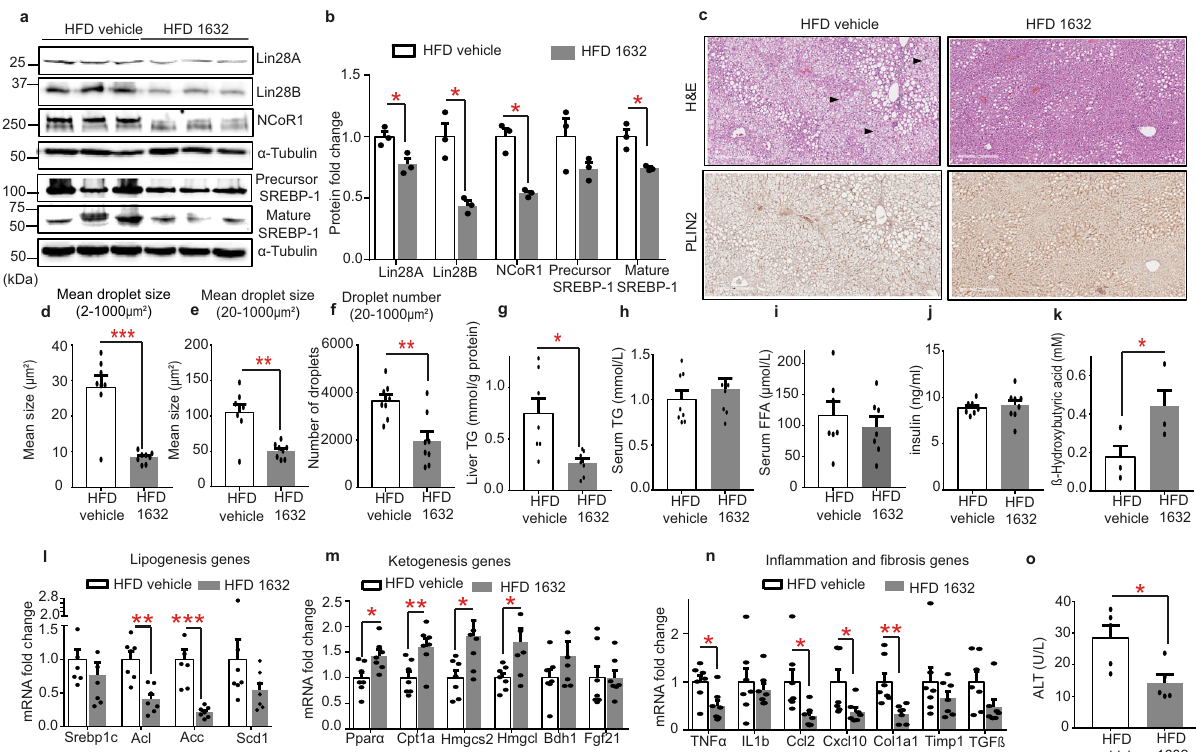
Fig. 6 | C1632 protects against high-fat diet (HFD)-induced NAFLD in mice. a , b Representative immunoblot and quantitative densitometric analyses for Lin28A, Lin28B, NCoR1 and SREBP-1 (precursor and mature form) in liversfrom 17- week-old male wild-type mice fed with HFD treated with vehicle or C1632 (50mg/ kg) after 4 weeks of treatment (5 IP injections per week). α -Tubulin was used as a loadingcontrol( n =3mice/group,Lin28A,* P =0.0272;Lin28B,* P =0.0258;NCoR1, * P =0.0167;M-SREBP1,* P =0.0467). c RepresentativeHematoxylinandeosin(H&E) staining and Perilipin (PLIN2) staining of liver sections from vehicle and C1632 (50mg/kg)-treated mice fed with a HFD. The arrowheads indicate ballooned hepatocytes. Scale bars correspond to 500 μ m. d – f Lipid droplet size and number were quanti fi ed by Image J ( n =8 histological images/group, d , *** P =0.0004; e , ** P =0.0018; f , ** P =0.0034). g Hepatic triglyceride (TG) content in mice fed a HFD and treated with vehicle or C1632, as described in ( a ) ( n =7 mice/group;